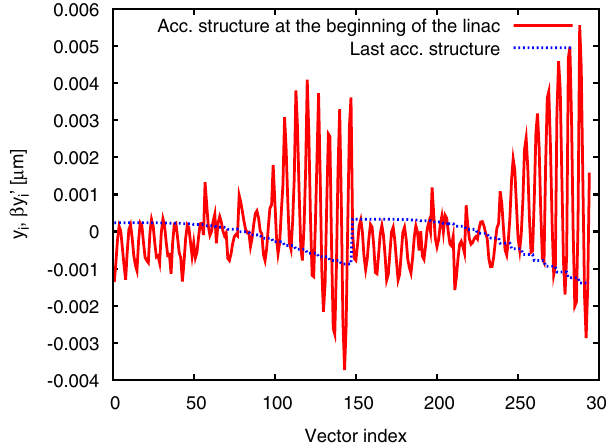
FIG. 7. Two knob vectors each corresponding to the displace- ment of an accelerating structure by 1 (cid:1) m . Observe that for the last accelerating structure the characteristic wakefield kick is clearly visible (same index convention as in Fig.